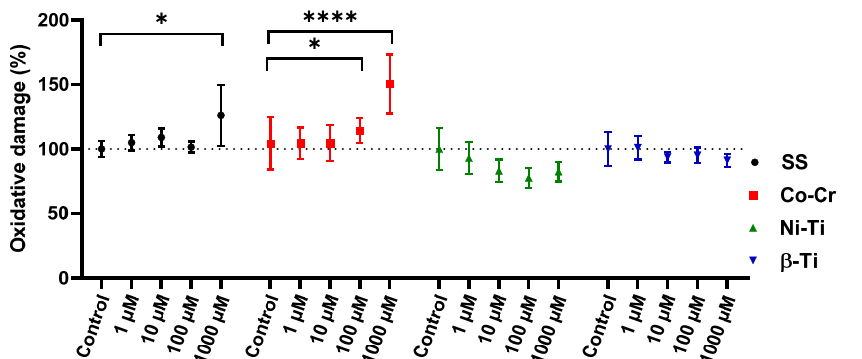
Figure 5. Protein carbonyl content as a result of oxidative protein damage as a result of cell treatment with various metal ions. The control sample was set at 100%, and the means with 95% confident interval are shown. Statistically different results are labeled with * (* p < 0.05, ** p < 0.01, *** p < 0.001, and **** p < 0.0001).